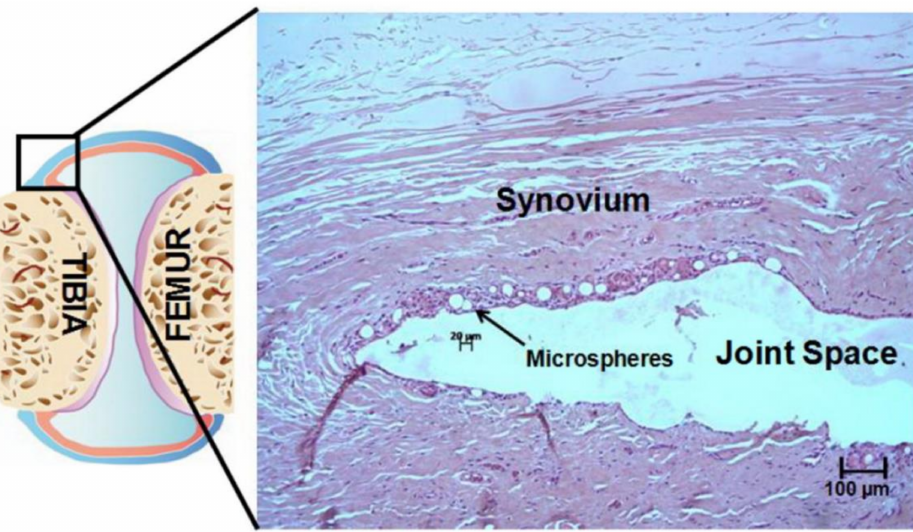
Figure 3. Histology image of a cross-section of the joint space and surrounding tissues, stained with hematoxylin and eosin, showing microspheres entrapped in the synovial tissue three weeks after injection into a healthy rat knee. Scale bar is 100 µ m. Reproduced with permission from [69]. © 2021